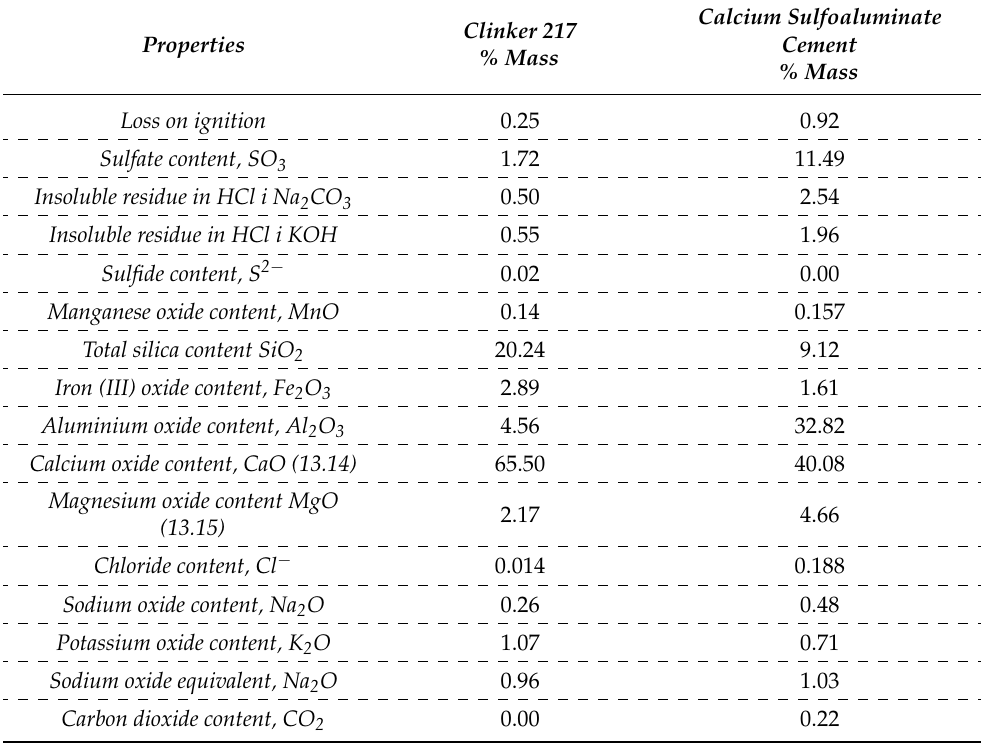
Table 1. Chemical composition of clinker 217. Analysis performed using Institute IGH d.o.o.